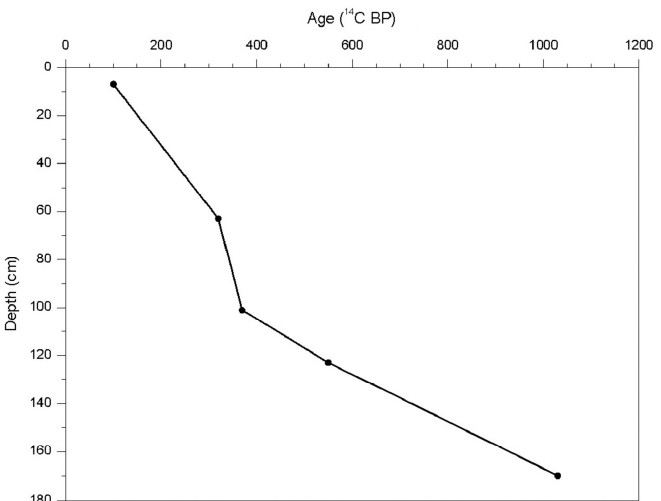
Fig. 3 – Age in relation to sediment depth.